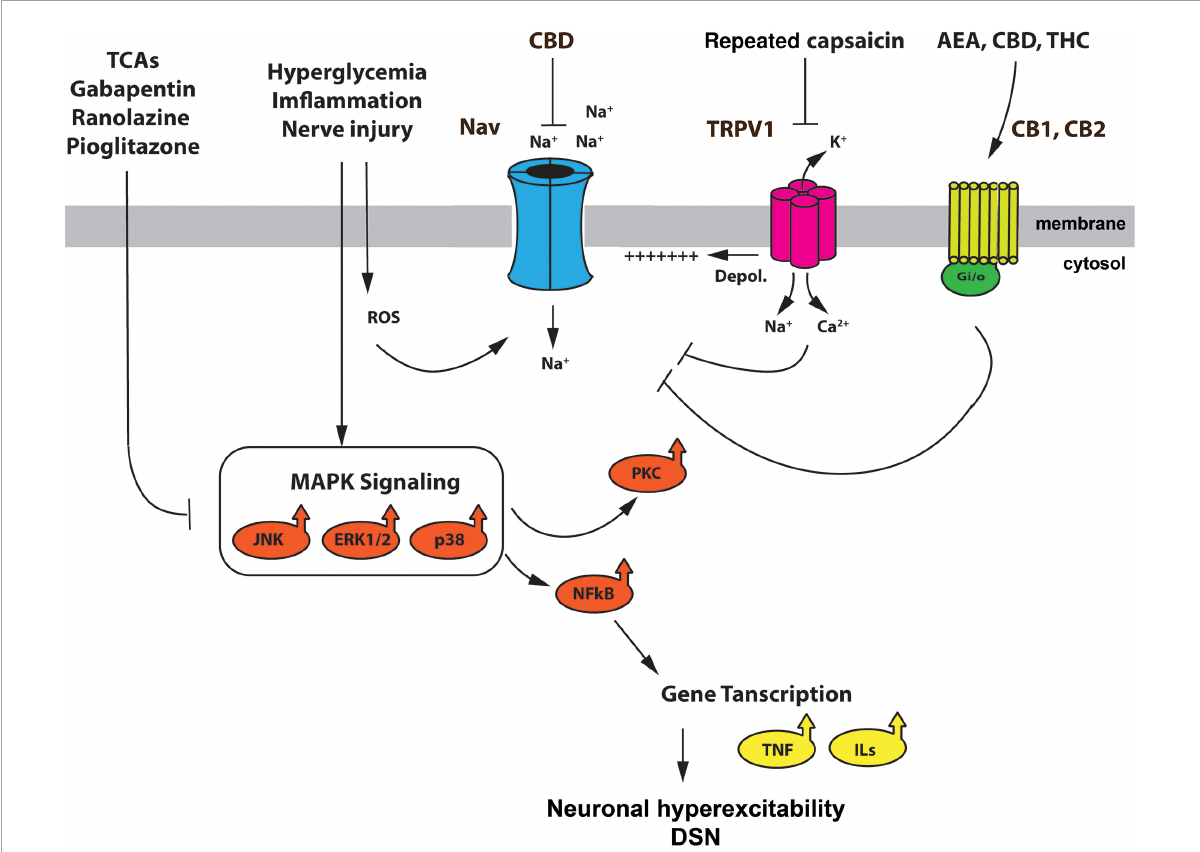
FIGURE1 Schematic representation summarizing the mechanisms modulating Na V channel function in DSN, and the effect of therapeutic agents. Hyperglycemia, nerve injury, and inflammation activate the MAPK kinase pathway and generate reactive oxygen species (ROS). The p38, ERK1/2 and JNK MAPKs, as well as ROS, have been reported to mediate upregulation and enhancement of different Na V channel subunits. Furthermore, MAPK signaling leads to PKC activation and expression NFkB. The latter supports the expression of interleukins and TNF-a further enhancing an inflammatory environment in DSN. TRPV1 channels, which are upregulated by hyperglycemia, inflammatory mediators, and ROS (Lam et al., 2018; Nair et al., 2021), depolarize DRG neurons and contribute to excitability in DSN (Jin et al., 2004; Hong and Wiley, 2005; Melli and Höke, 2009) by assisting the cell in reaching threshold voltage for activation of Na V channels. The use of FDA approved drugs for the treatment of DSN such as TCA, gabapentin, ranolazine and pioglitazone, reduce the activation of the MAPK pathway, preventing the upregulation of some Na V channels, such as Na V 1.7. Furthermore, tonic (repeated) application of capsaicin prevents the upregulation of Na V channels by cAMP mediated signaling pathways. Agonist of the ECS, such as AEA, THC, and CBD, can prevent Na V channel upregulation by actions through they receptors (CB1, CB2), or by direct action on the Na V channel. Although these effects of cannabinoids have yet to be tested in the context of DSN, they do, however, provide a mechanistic explanation of some of the beneficial effects of cannabinoid therapy in diabetic patients with symptoms of DSN. TCAs, tricyclic antidepressants; ROS, reactive oxygen species; ECS, endocannabinoid system; AEA, N arachidonoylethanolamine, CBD, cannabidiol; THC, (cid:49) 9-tetrahydrocannabinol; CB1, cannabinoid receptor 1; CB2, cannabinoid receptor